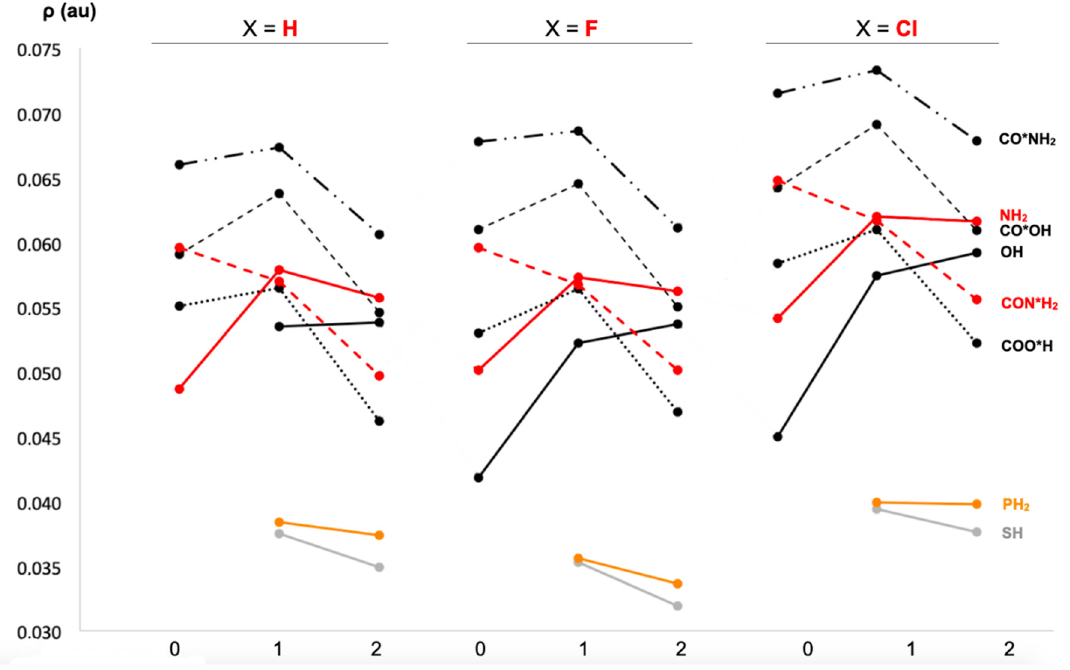
Figure 6. Electron density values (au) according to substitution patterns for ortho -substituted benzenes. The number of (CH 2 ) groups in the different systems is indicated in the X axis.